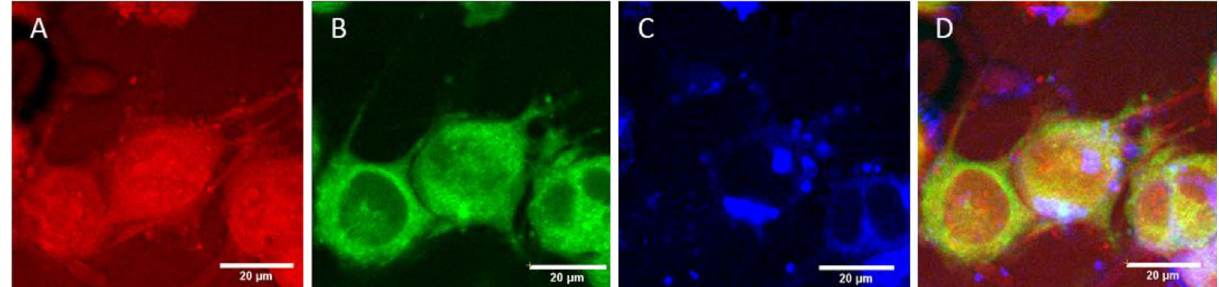
Figure 3. In vitro imaging capabilities of MANTIS. NG108 cells observed with CARS ( A ) at 2830 cm −1 , a